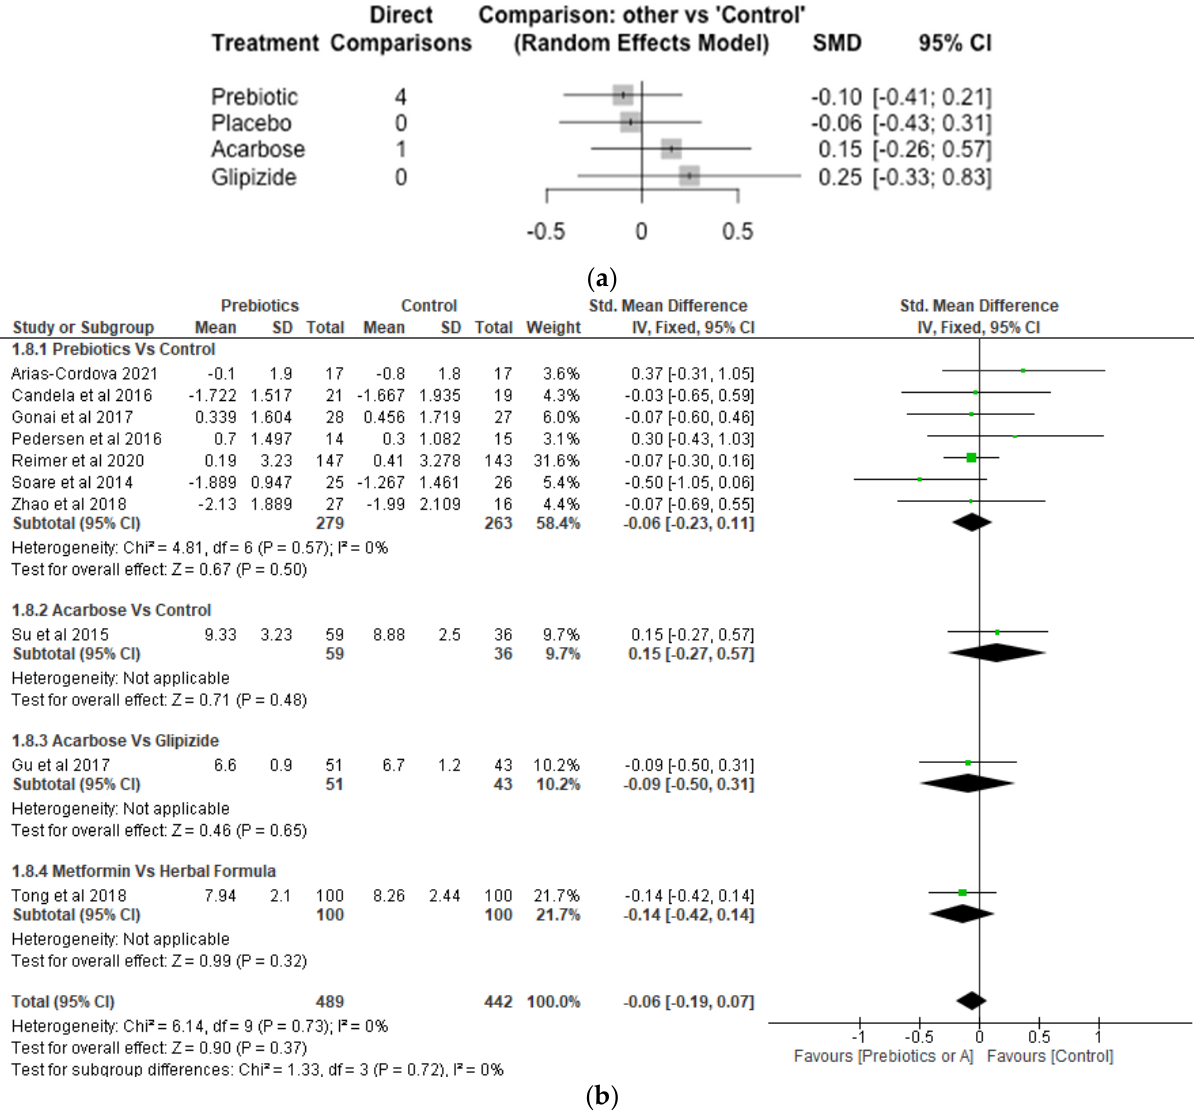
Figure 7. Network Meta-analysis ( a ) and Meta-analysis ( b ) of the effect of treatments versus control on Fasting Blood Glucose [32,36,38–43,45,46,48]. Postprandial Blood